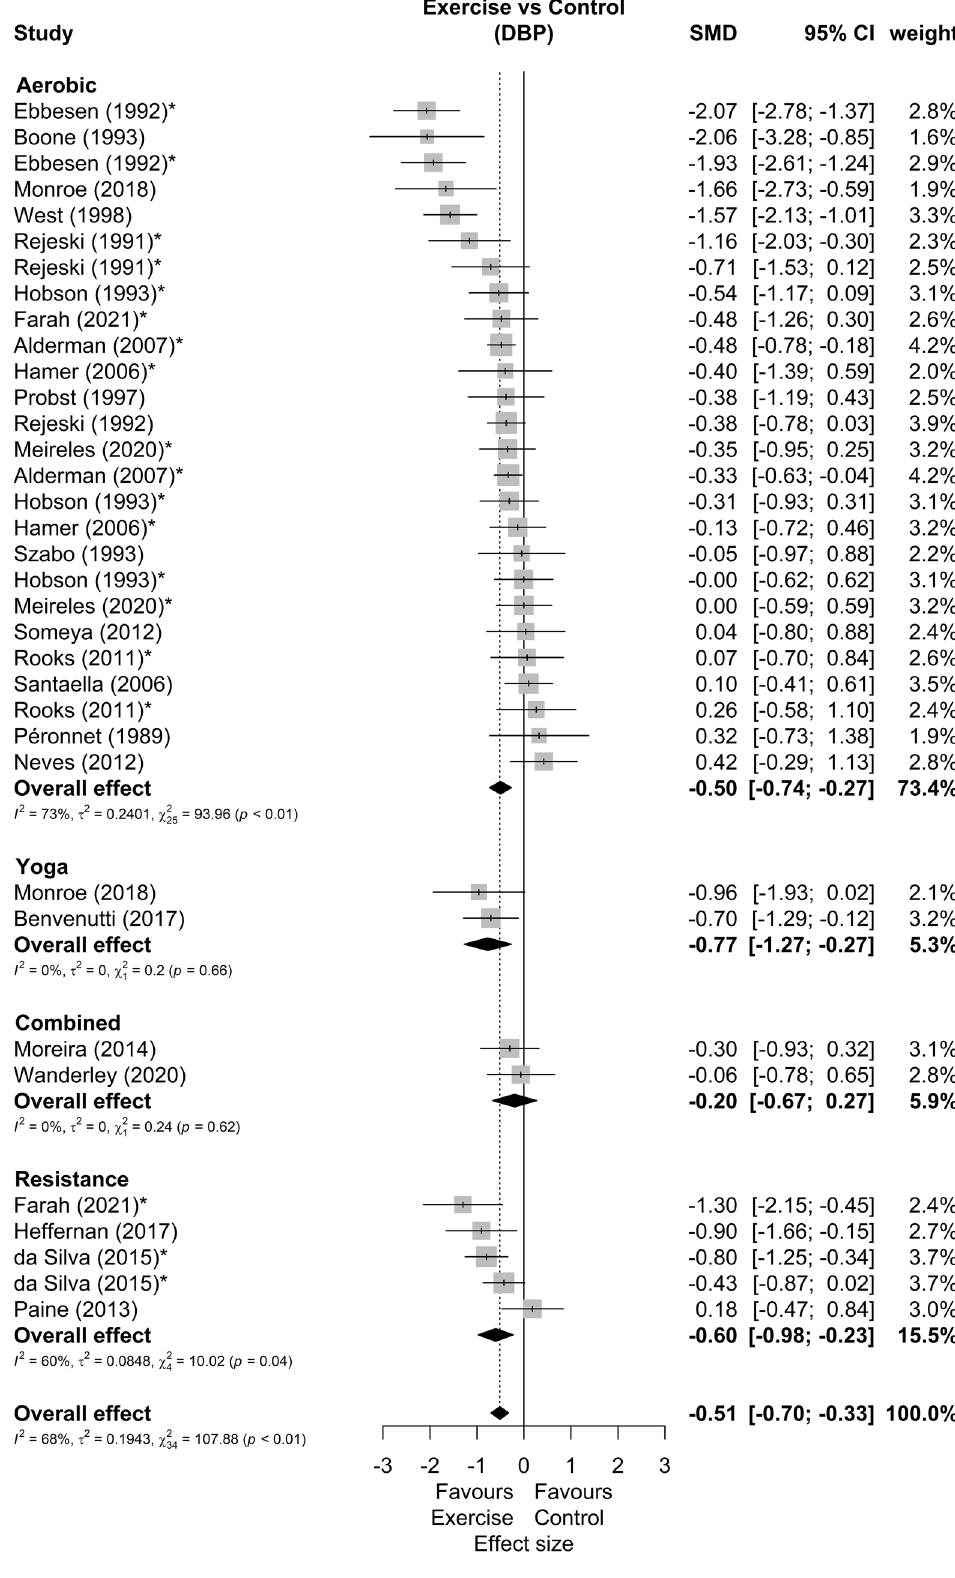
Figure 3. Diastolic blood pressure reactivity forest plot. SMD, standardized mean difference; DBP, diastolic blood pressure; CI, confidence interval; *, studies with multiple